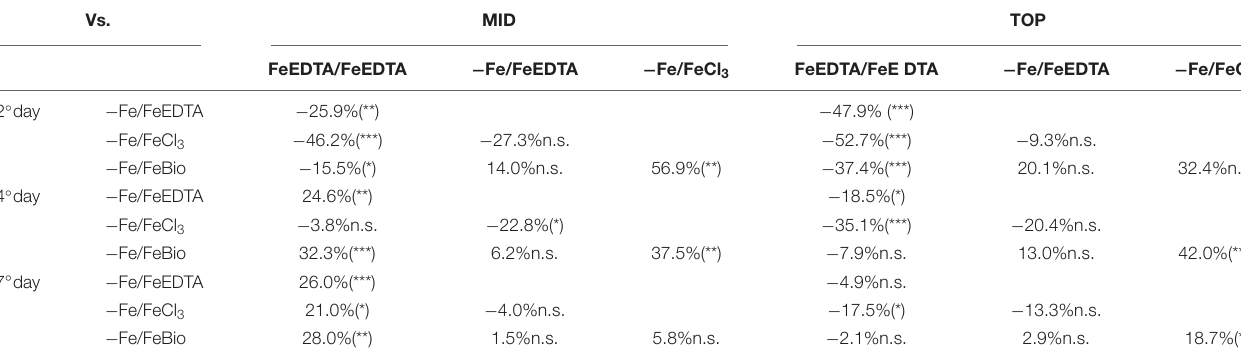
Percentage variations of SPAD values recorded at mid-leaf (MID) and top-leaf (TOP) after 2, 4 or 7 days of Fe supply. Student’s t-test was applied, *p < 0.05; **p < 0.01; ***p < 0.001.